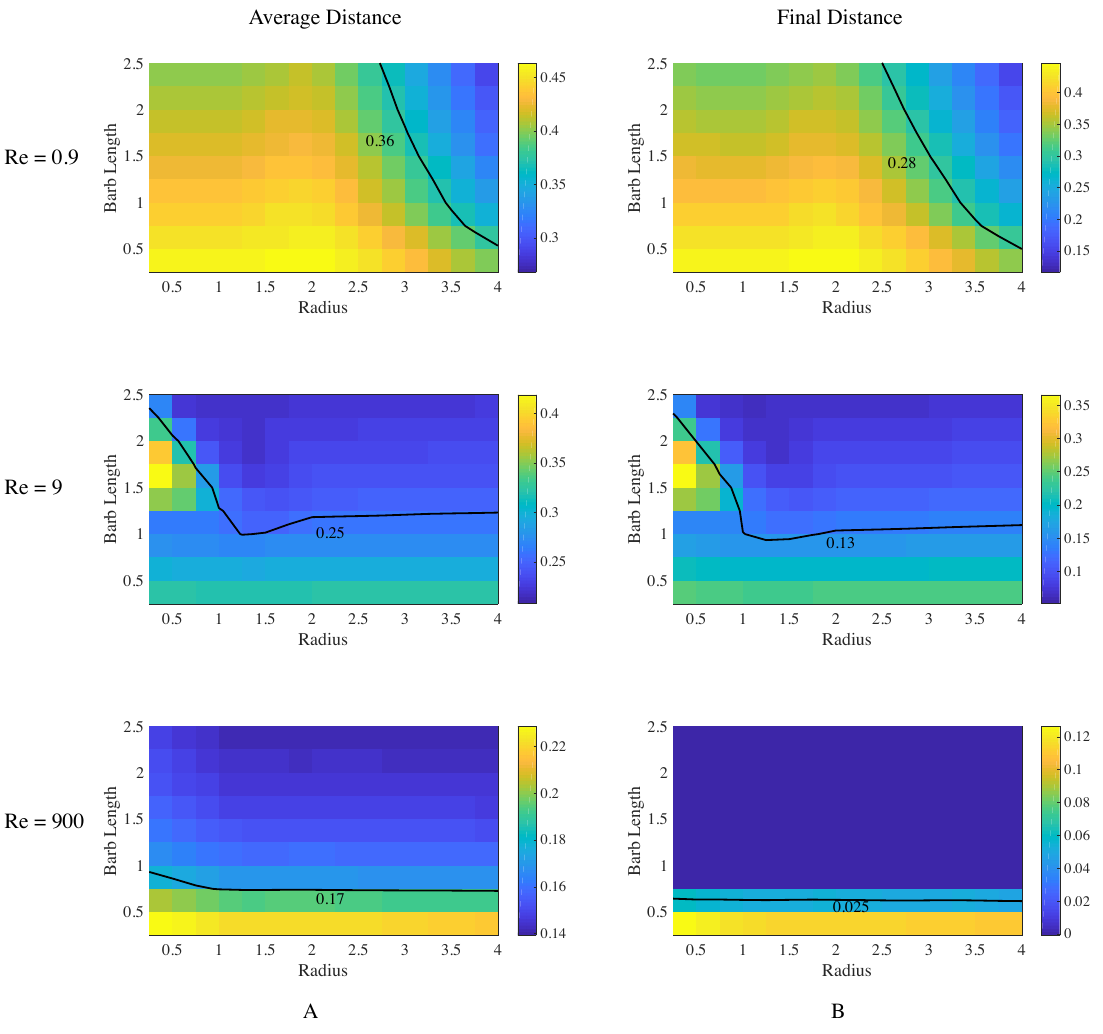
Figure 11. Phase diagram for average (column ( A )) and final (column ( B )) distance between the barb and the prey divided by the initial distance of 10 − 5 m, Re = 0.9, Re = 9, and Re = 900. The parameter values of barb length and prey radius are listed as multiples of the base values of L and R in Table 2. The values of the average and final distance are listed next to their corresponding